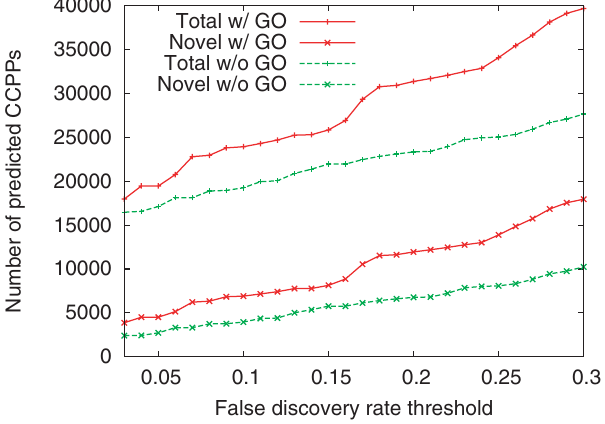
Figure 6. Total number of predicted CCPPs as a function of FDR threshold. The red and green series correspond to classifiers trained with and without GO term annotations, respectively. The upper two series (marked with ‘‘ + ’’ signs) represent the total number of predictions, and the lower two series (marked with x’s) represent the number of novel predictions (i.e., excluding protein pairs in the MIPS complex catalogue).